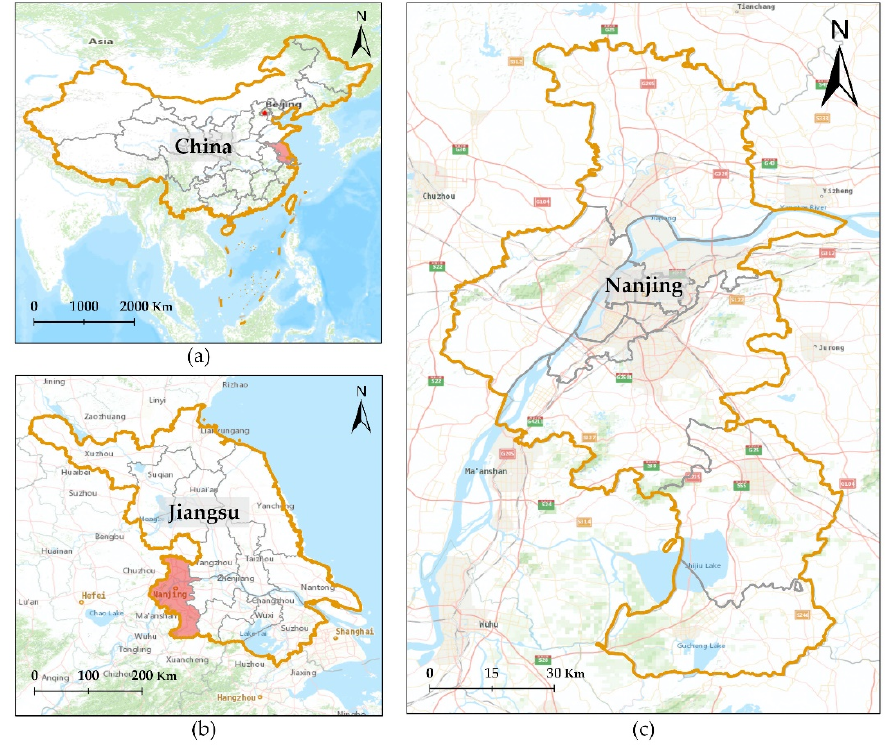
Figure 1. Study area. ( a ) China, ( b ) Jiangsu Province, ( c ) Nanjing City.